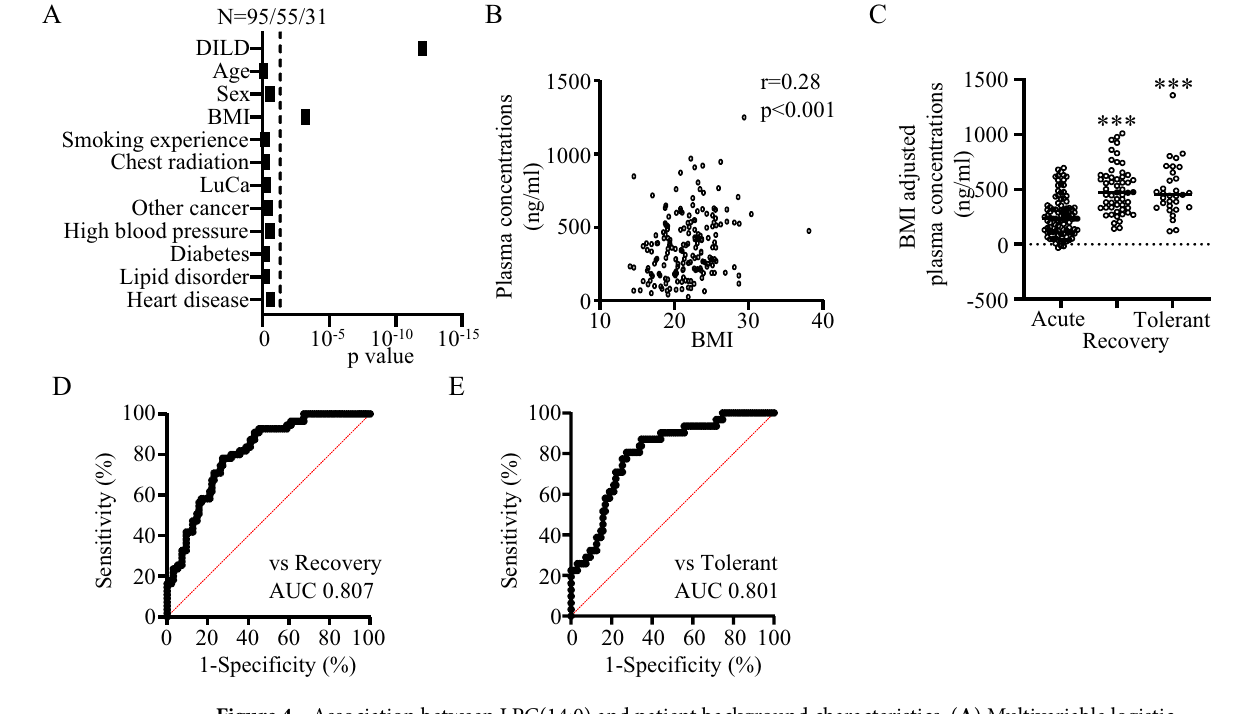
Figure 4. Association between LPC(14:0) and patient background characteristics. ( A ) Multivariable logistic regression analysis of the characteristic contribution to plasma LPC concentrations. ( B ) Plasma LPC(14:0)